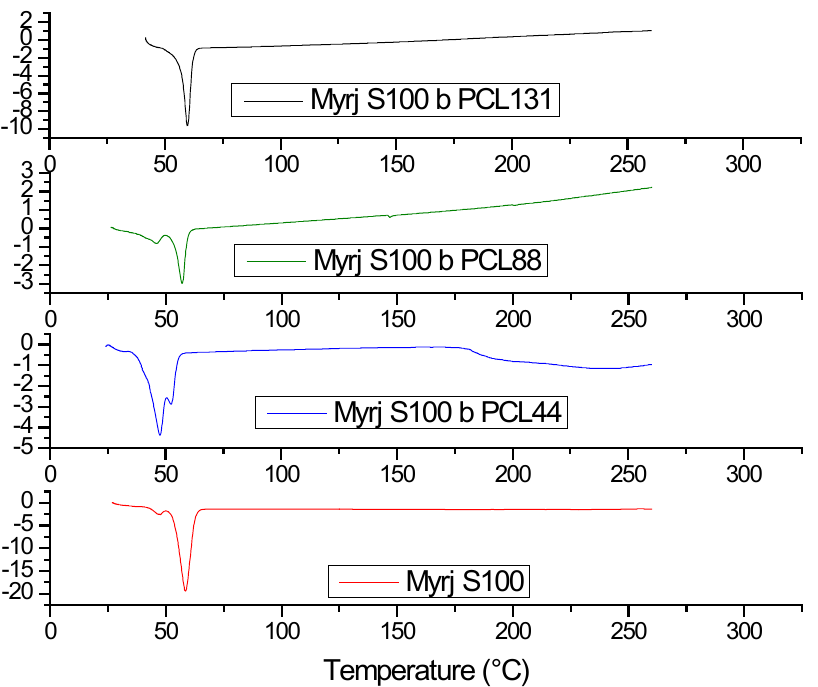
Figure 6. DSC thermograms of Myrj S100, Myrj S100- b -PCL 44 , Myrj S100- b -PCL 88 , and Myrj S100- b - PCL 131 .